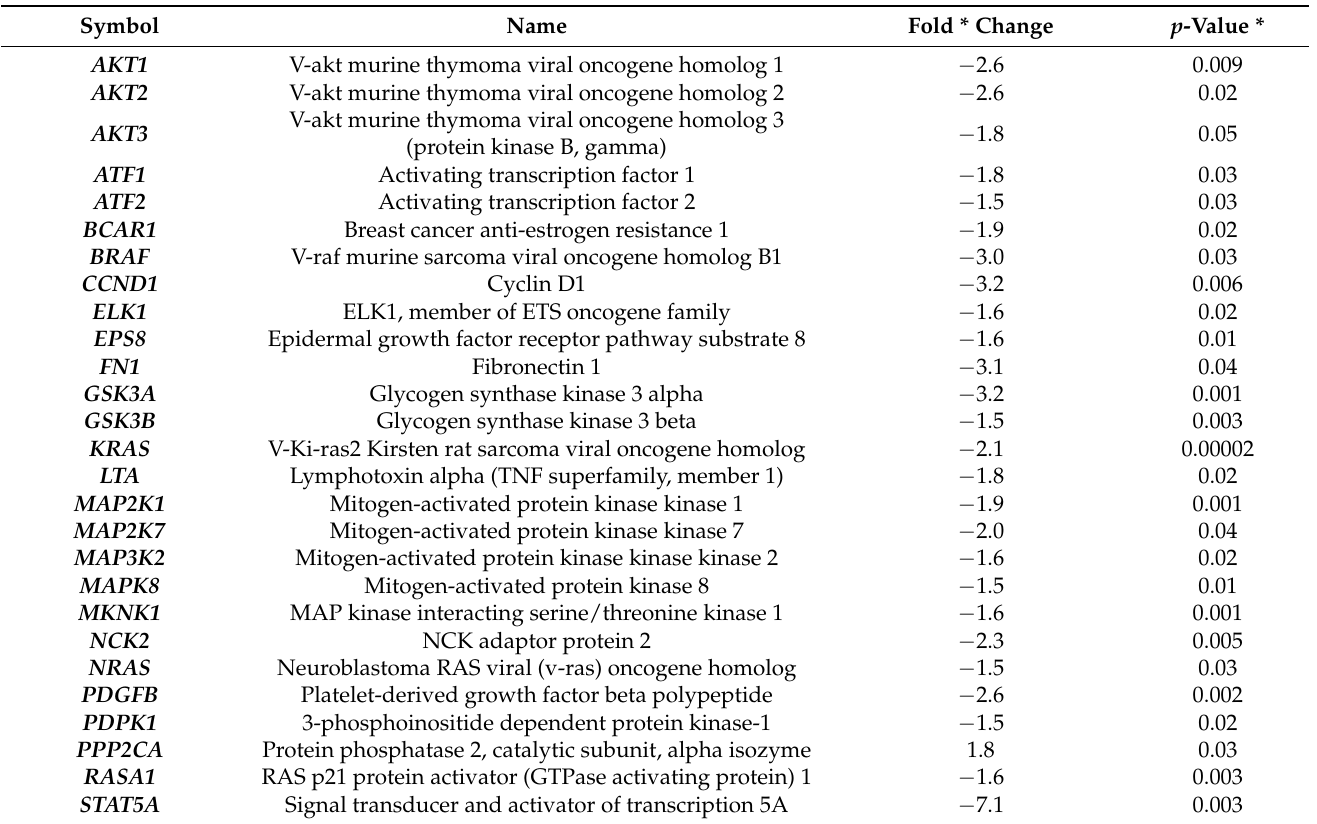
Table 1. In vivo effects of SCAMP3 depletion on the expression of EGF/PDGF signaling pathway